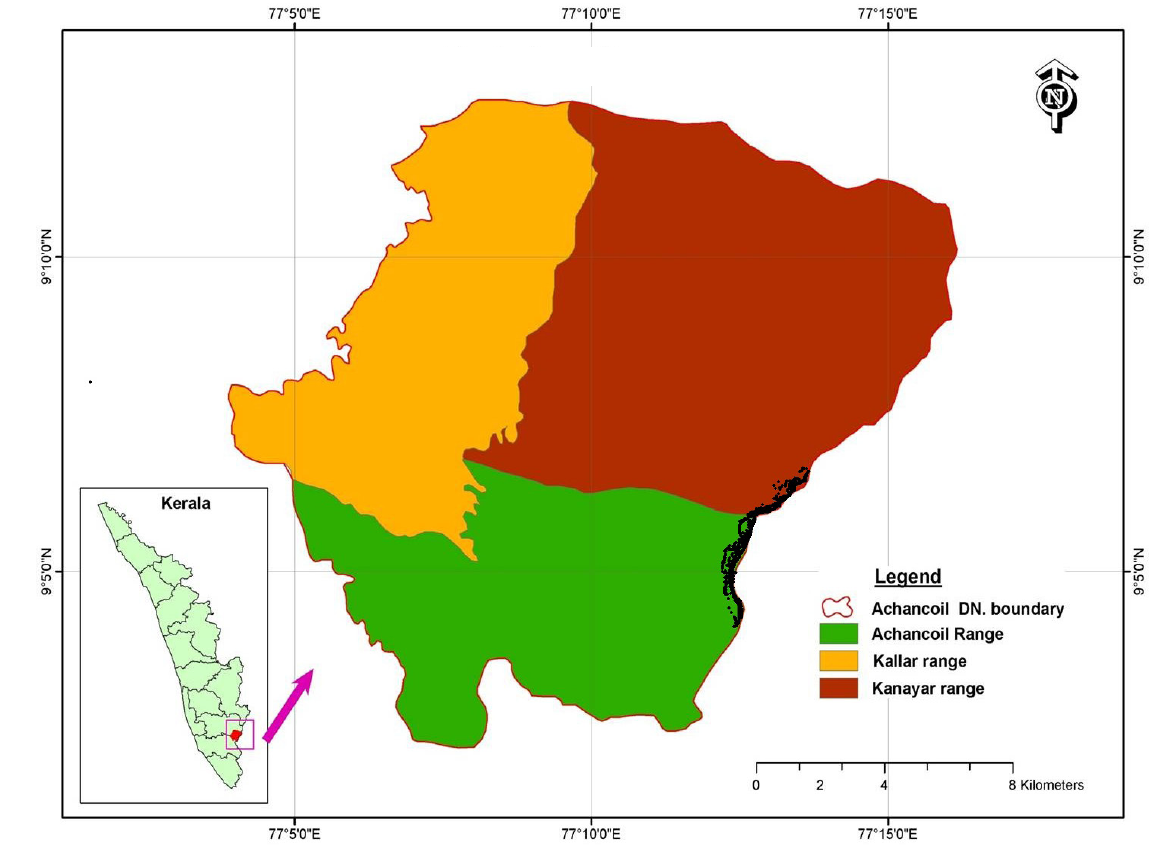
Figure 1. Kottavasal Hills marked in the map of Achancoil Forest